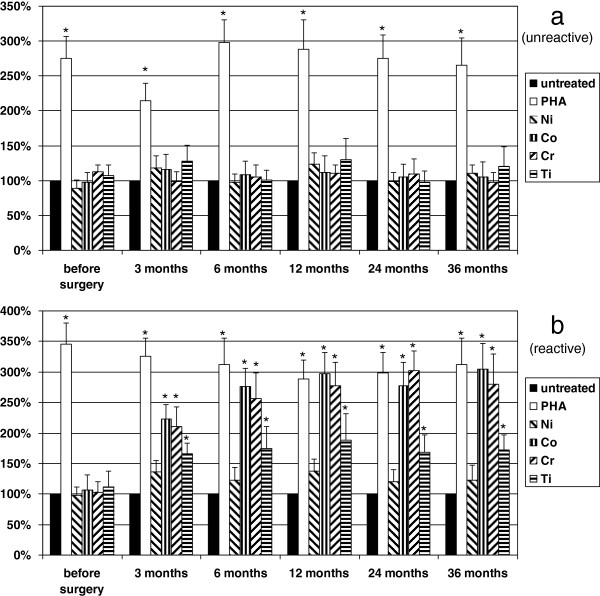
The effect of various metals and PHA on TNF-α production of patients’ leukocytes. The effect of various metals (Ti 0.01 mM, Co 0.1 mM, Cr 0.1 mM, Ni 0.1 mM) and PHA (0.1 mg/ml) on TNF-α production of patients’ leukocytes in group 3 is shown. Cells were untreated or treated as indicated. (a) (unreactive) it is clearly demonstrated that metal challenge did not influence significantly the cytokine release before and after the surgery. (b) (reactive) however, Co, Cr, and Ti increased the TNF-α secretion significantly 3 months after surgery in 21% (8 patients) of group 3, which was increased up to 30% (12 patients) after 36 months, distinguishing a subgroup referred here as metal-sensitive patients in group 3. Positive control PHA increased TNF-α production significantly in each experiment. Columns represent means + SD, level of significance is shown, *p < 0.05. Note that Ni did not influence TNF-α secretion significantly.